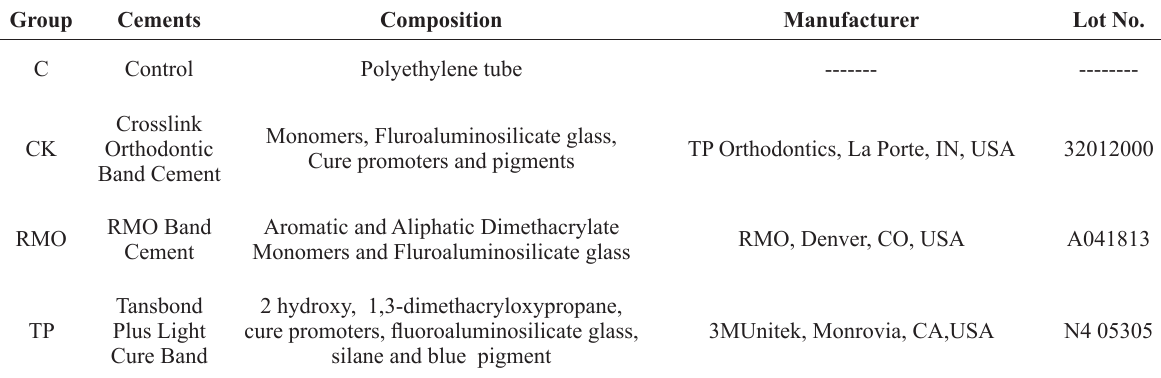
Composition of Transbond ® , Crosslink ® and RMO® cements evaluated in this